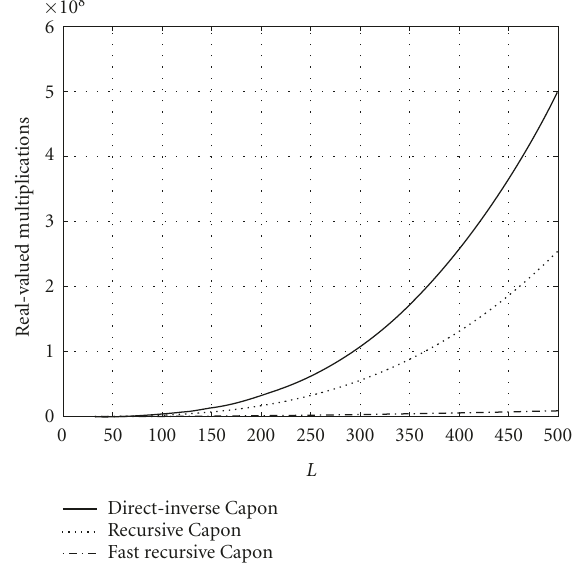
Figure 1: Comparison of computational complexity among the direct-inverse, the recursive, and the fast recursive Capon algo- rithms for di ff erent L ’s in the condition where N = L = K .